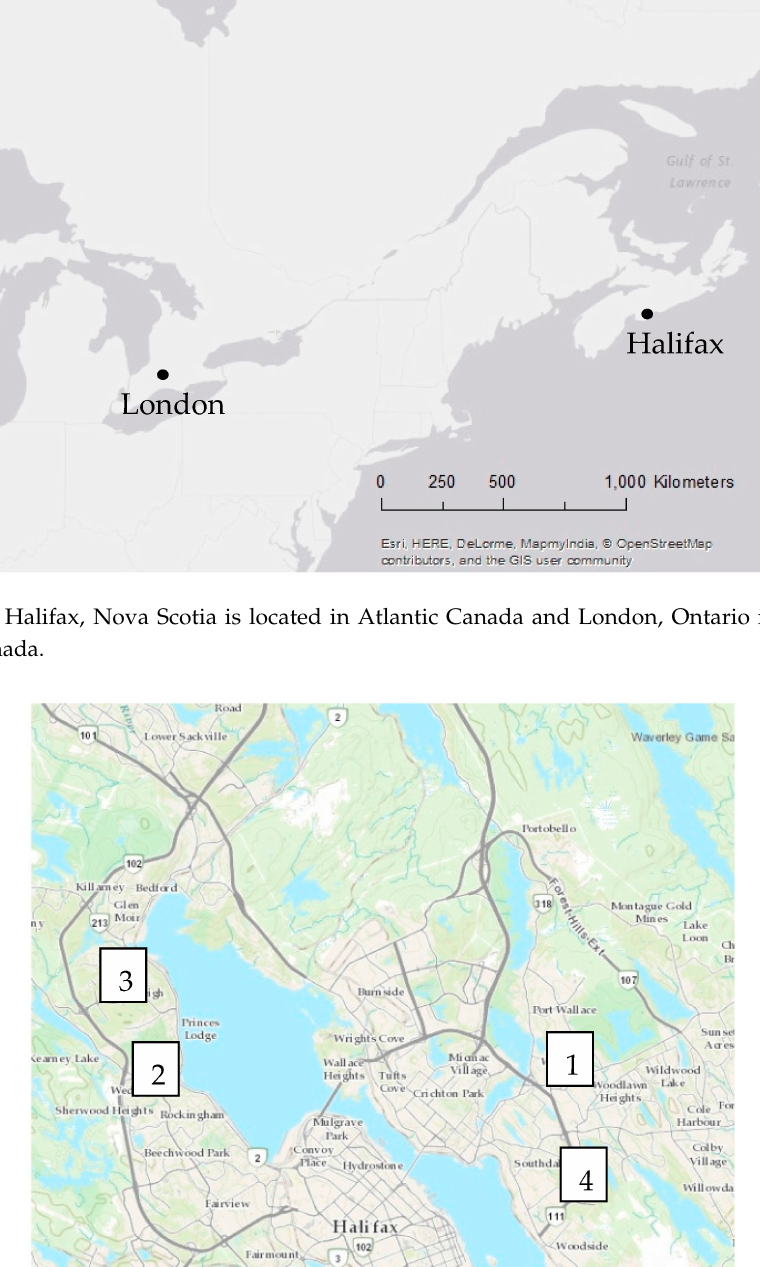
Table A4. Contingency table for test “L” (all neighbourhoods in London).